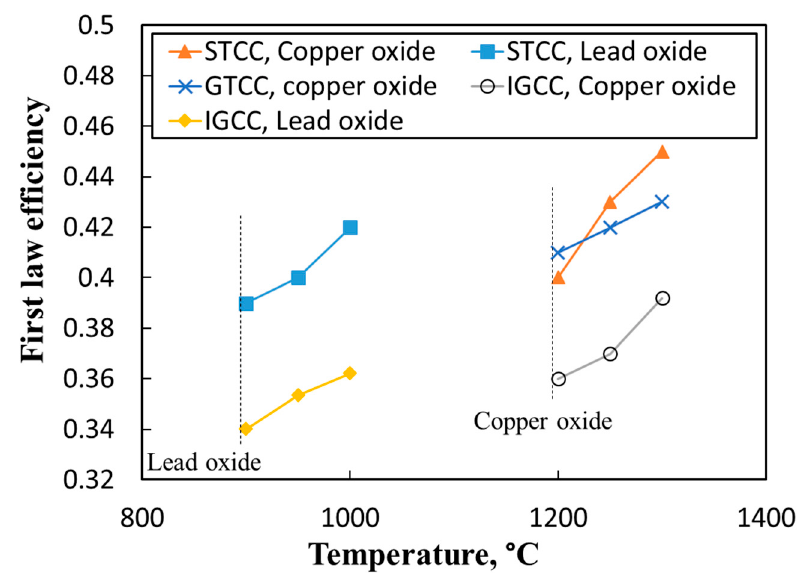
Figure 7. Dependence of first law efficiency (FLE) and produced work by steam turbines on the temperature of the air reactor for the LCLG-IGCC power block.